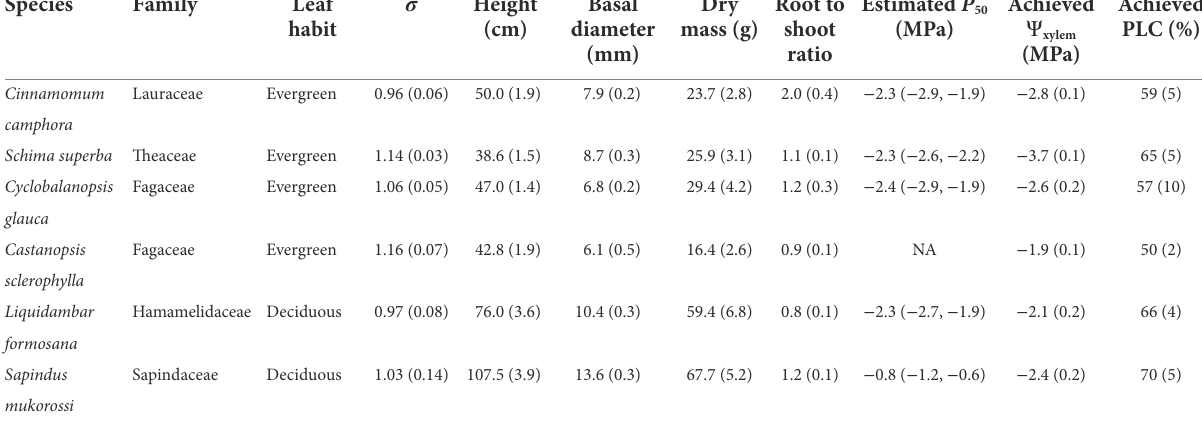
TABLE 1 Plant traits for the tree species used in this study. Species Family Leaf